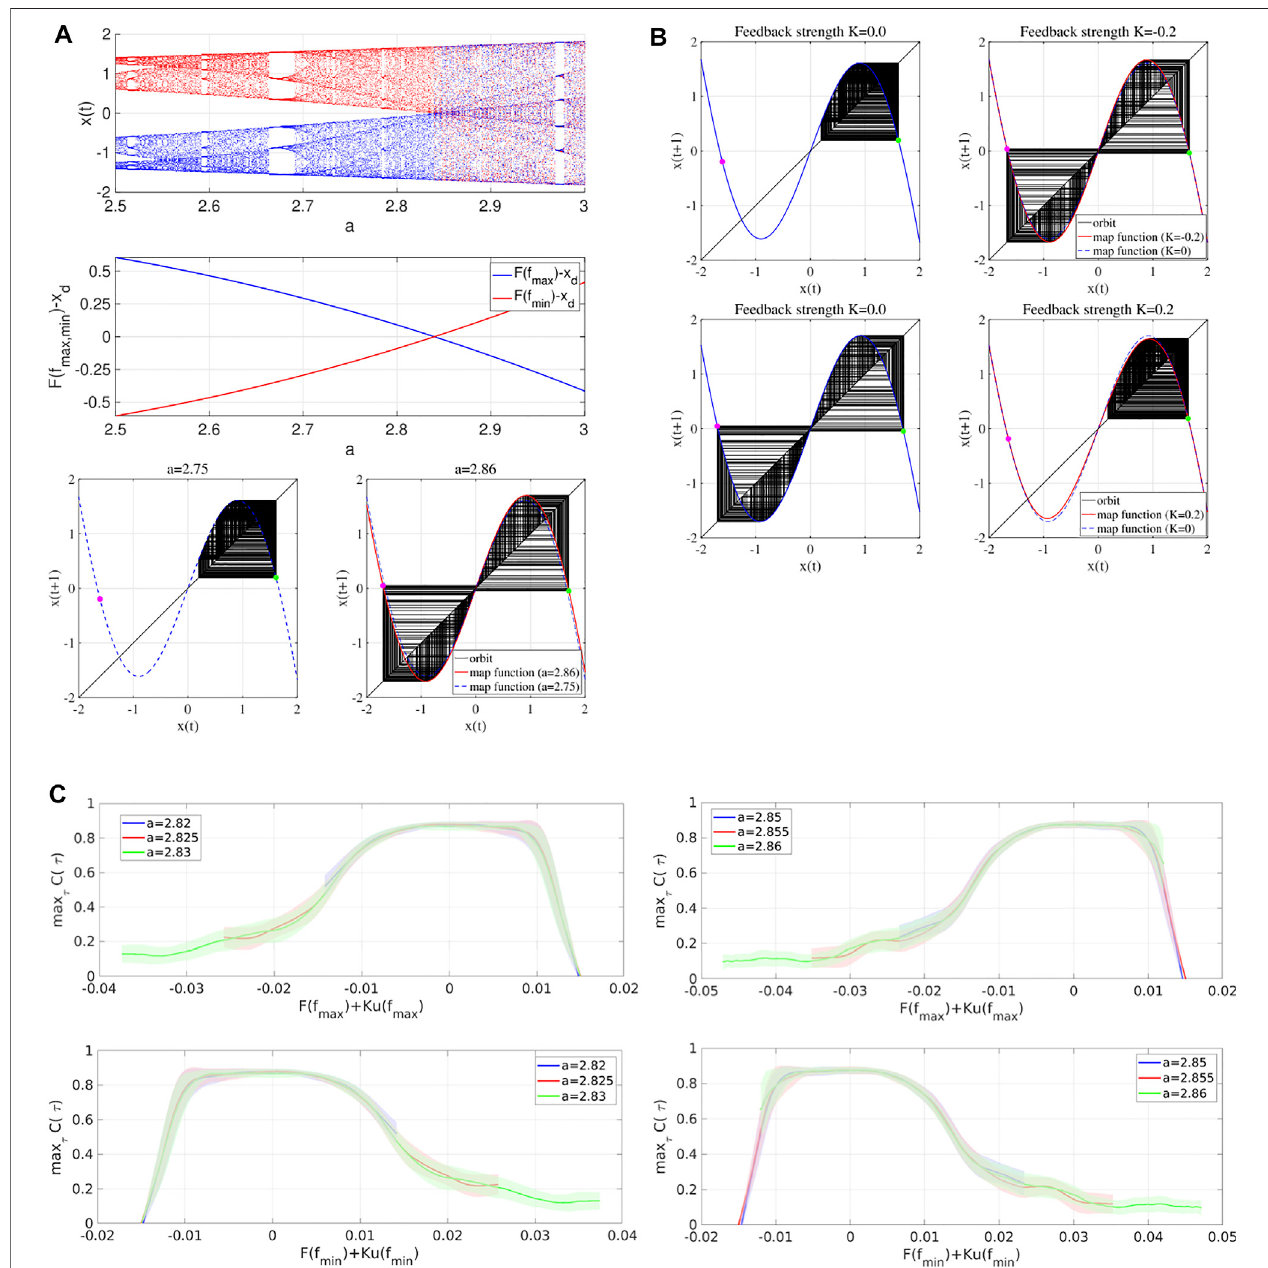
FIGURE1|(A) Dependenceofsystembehaviorsontheinternalparameter.Thebifurcationdiagramisshownasafunctionoftheinternalsystemparameter a .The redandbluedotsindicatenegativeandpositive x (0)cases (toppart) ,respectively,andtheattractor-mergingcondition F ( f max,min ) − x d isshown (middlepart) ( b (cid:2) 10, x d (cid:2) 0). The orbit, map functions, and attractor-merging condition F ( f − x max,min ) d (indicated by magenta and green dots, respectively) are also shown (bottom part) . (B) Attractor-merging and separating achieved by “ reduced region of orbit ” (RRO) feedback signals in a cubic map ( b (cid:2) 10, σ (cid:2) 0.6). The orbit, map functions, and attractor-merging condition F ( f max,min )+ Ku ( f max,min ) − x d (indicatedbythemagentaandgreendots,respectively)undertheattractor-separatingcondition( a (cid:2) 2.75, K (cid:2) 0) (left-hand sideintheupper section) andthose underthe attractor-mergingcondition inducedbytheRRO feedback signal withanegative strength ( K (cid:2) − 0.2) (right-hand side in the upper part) are shown. The orbit, map functions, and attractor-merging condition F ( f max,min ) + Ku ( f max,min ) − x d under the attractor-merging condition of a (cid:2) 2.86, K (cid:2) 0 (left-hand side in the bottom part), as well as those under the attractor-separating condition induced by an RRO feedback signal with a positive strength ( K (cid:2) 0.2) (right-hand side in the bottom part) are shown. (C) Ability of the signal response measured by the correlation coef fi cient max τ C ( τ ) as a function of the attractor- merging condition F ( f max,min ) + Ku ( f max,min ) − x d in thecase where attractor-merging isinduced bytheRRO feedback signal( a (cid:2) 2.82, 2.825,2.83) (left side) ,and where attractor-separating is induced by the RRO feedback signal ( a (cid:2) 2.85, 2.855,2.86) (right side) . Solid line and shaded area represent the mean and standard deviation, respectively, among 10 trials with different initial x